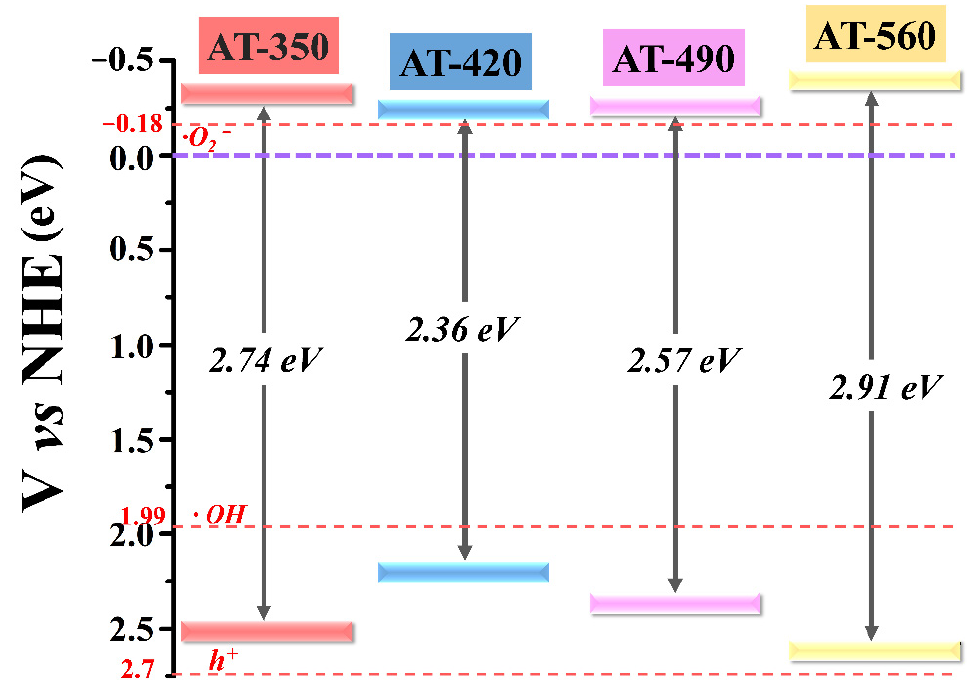
Figure 5. The bandgap structures of all samples.